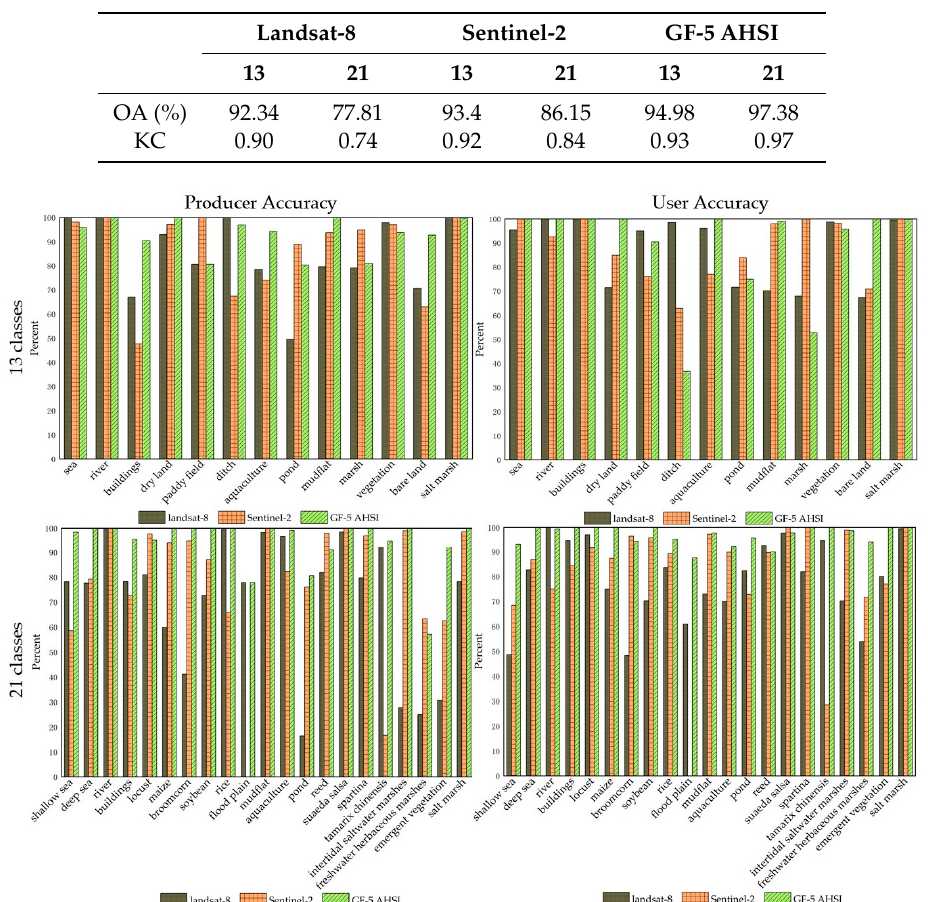
Table 7. The comparison of PA and UA between HCF on the Yellow river estuary Landsat-8, Sentinel-2 and GF-5 AHSI data.